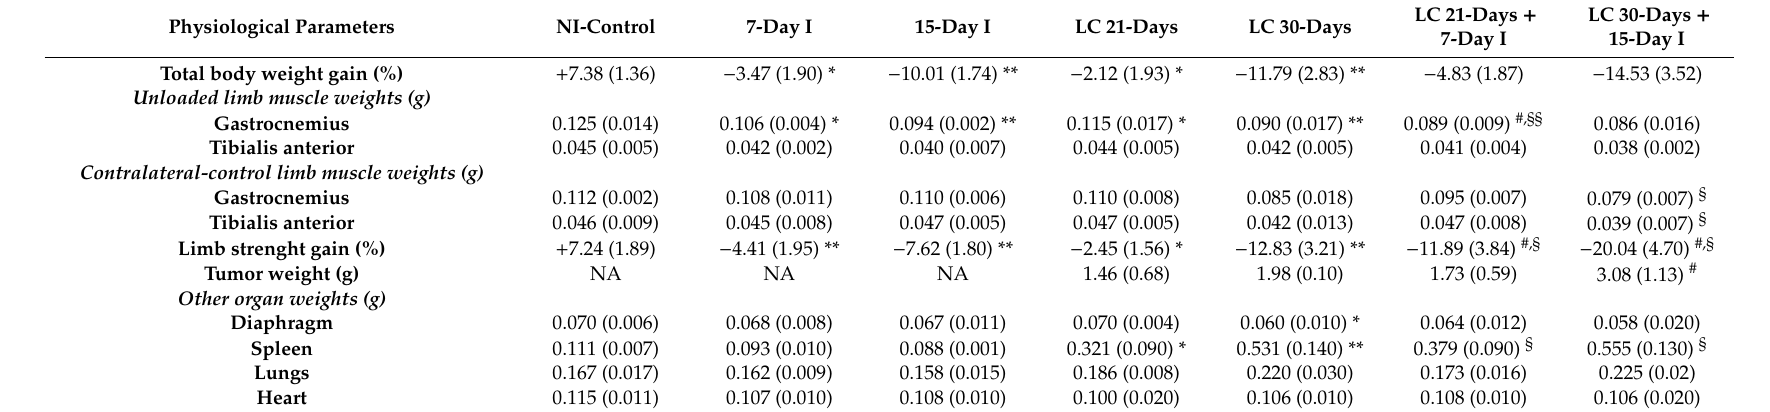
Table 1. Physiological parameters in all the experimental groups of